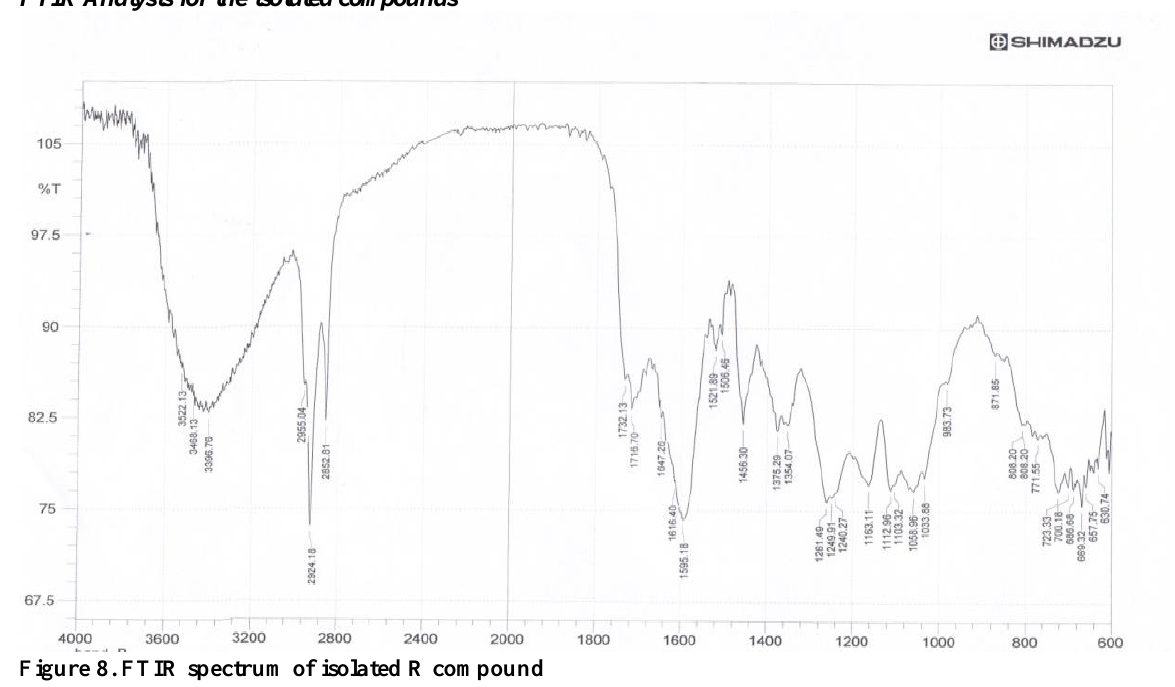
Figure 8. FTIR spectrum of isolated R compound